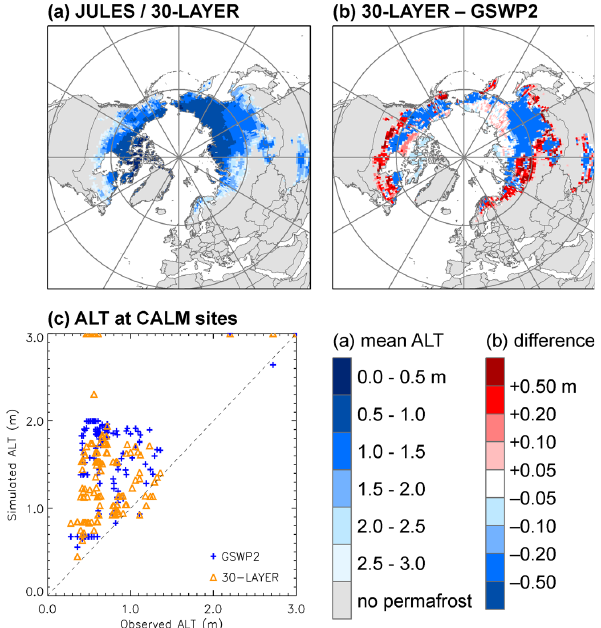
Fig. 10. (a) Mean ALT over 1983–1995 in a GSWP2 run with the soil column divided in 30 layers of 10cm (cf. Fig. 1); (b) difference in ALT with the standard setup of four layers; and (c) comparison of simulated ALT from both runs with observations at CALM sites (cf. Fig. 2). Colours in (b) are as in Fig. 5 but note the scale is